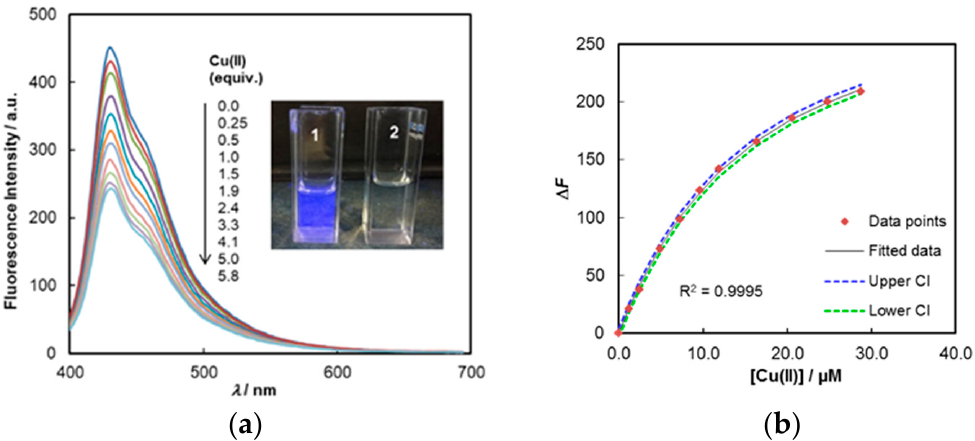
Figure 2. ( a ) Emission spectra of polymer 5 (5.0 × 10 − 6 M in CH 3 CN) upon addition of increasing amounts (0.25 − 5.8 equivalent) of Cu(ClO 4 ) 2 ( λ exc = 380 nm). Inset: photo of polymer 5 fluorescence under UV irradiation (366 nm) before ( 1 ) and after ( 2 ) Cu(ClO 4 ) 2 addition (5 equivalent); ( b ) Binding isotherm for the fluorimetric titration of 5 with Cu(II) with fitted curve and confidence intervals (see